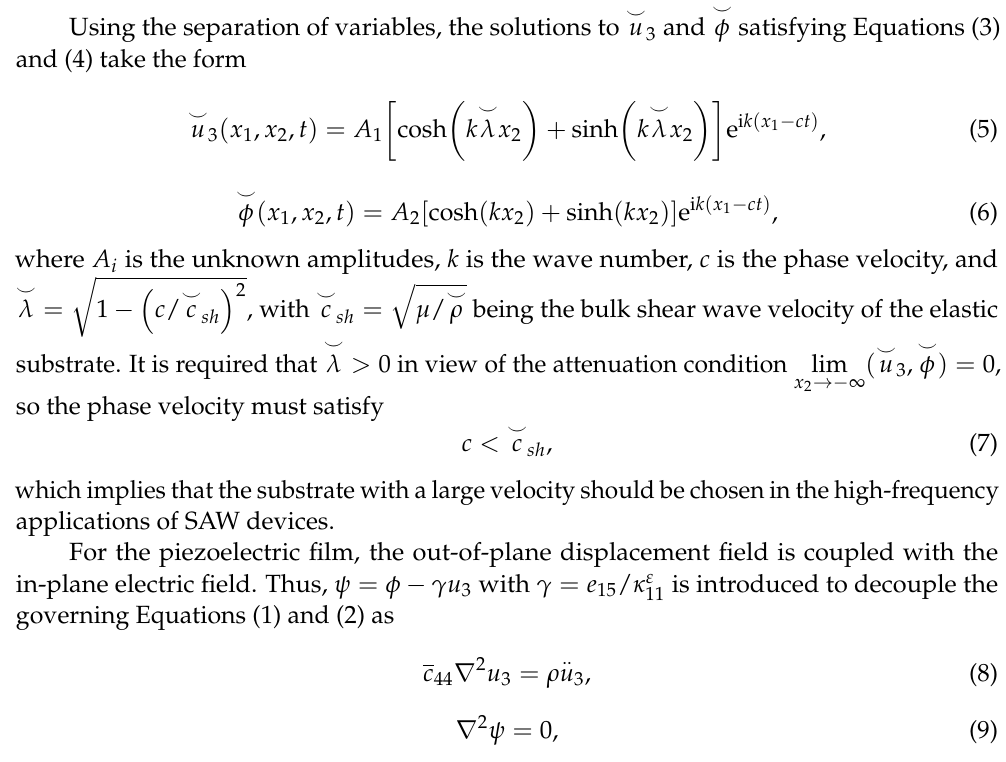
Figure 1. Geometry and coordinate systems of the problem.